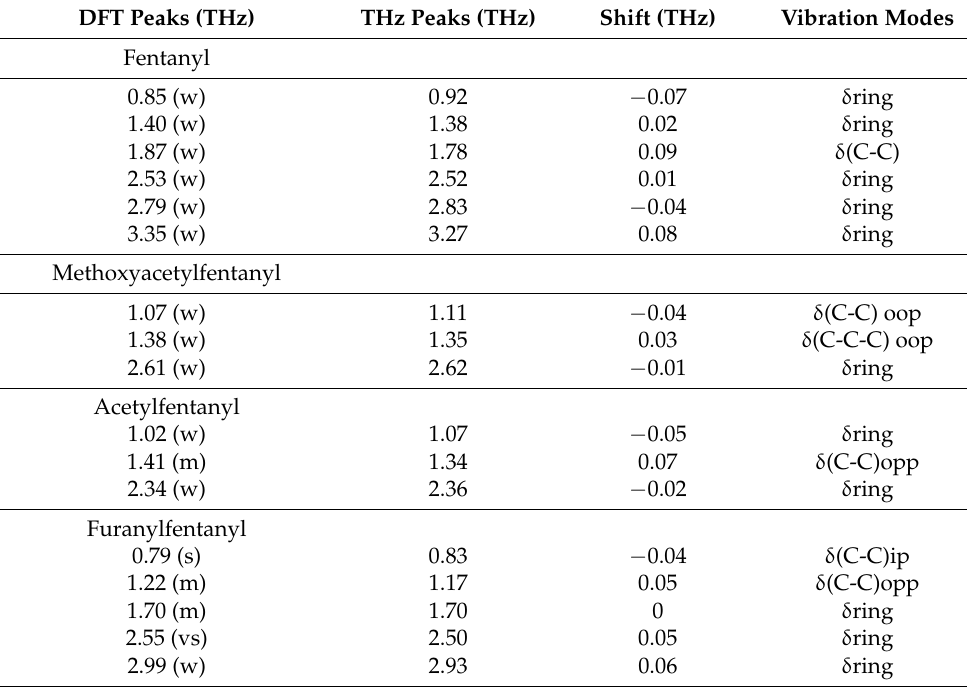
Table 1. Assignment of the absorption